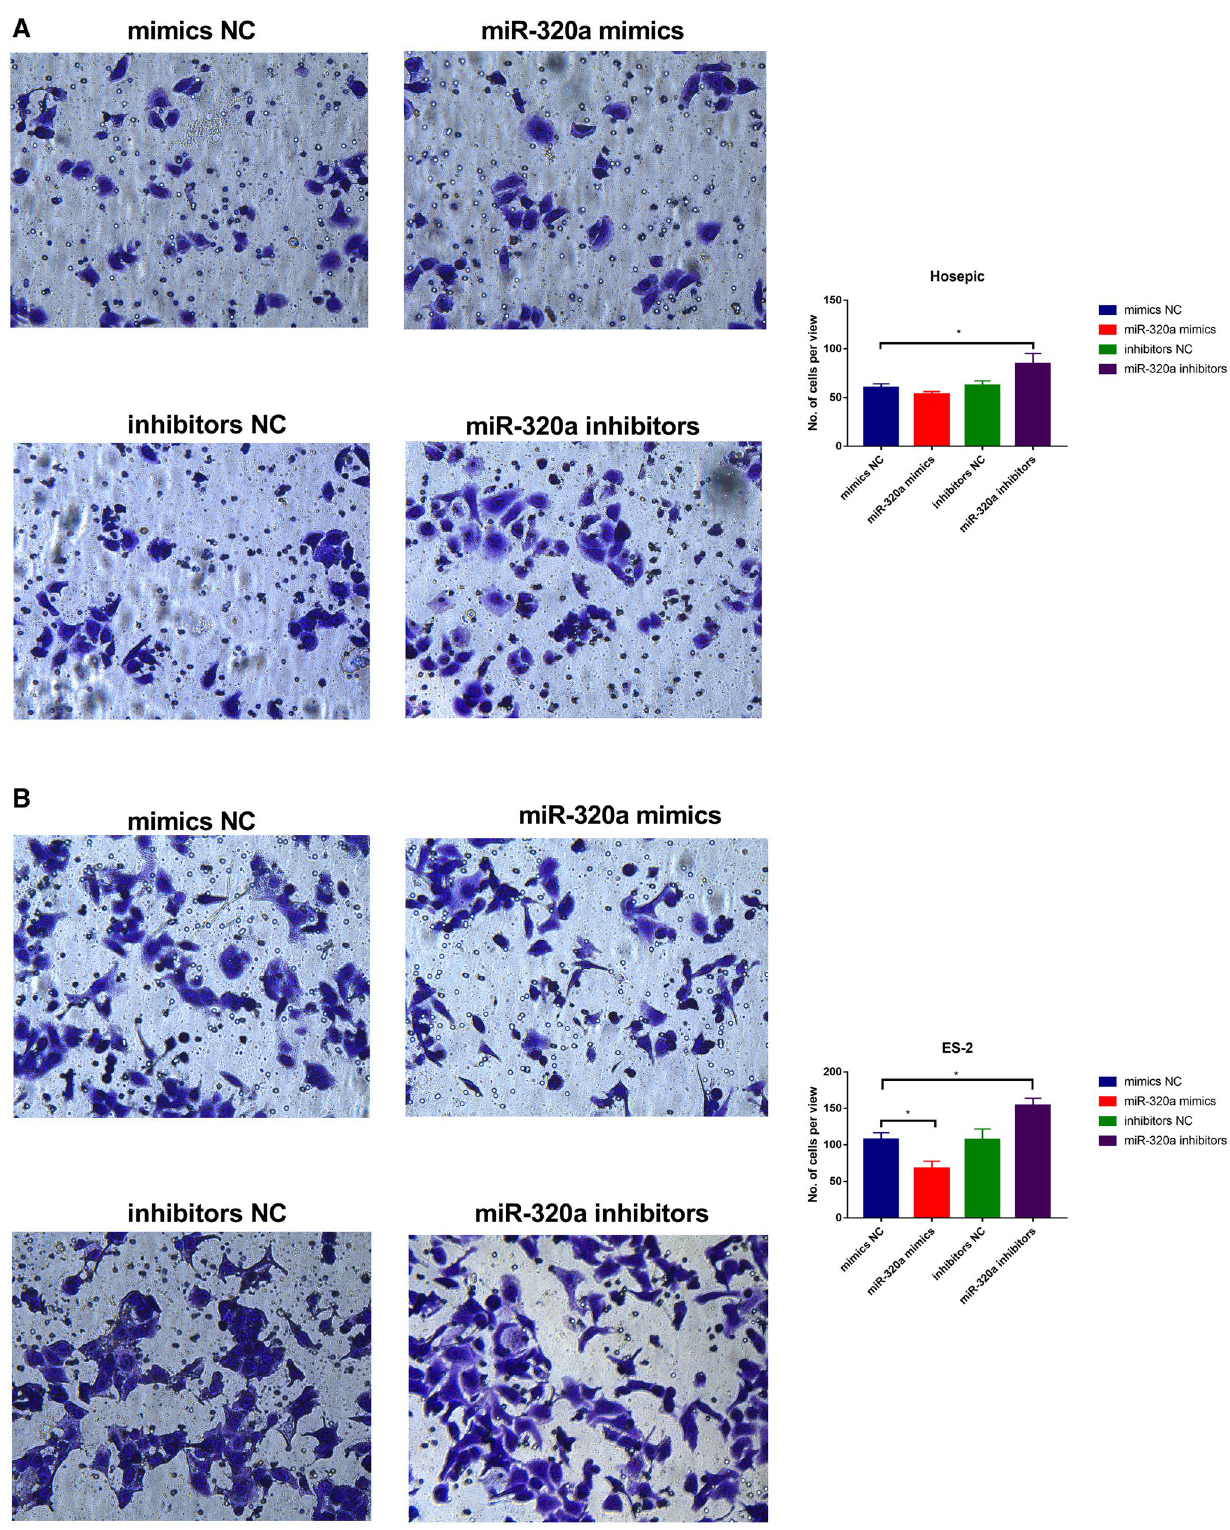
Fig. 6 The role of miR-320a in cell migration. A Migration study of mimics NC, miR-320a mimics, inhibitors NC, and miR-320a inhibitors in Hosepic cells. B Migration study of mimics NC, miR-320a mimics, inhibitors NC, and miR-320a inhibitors in ES-2